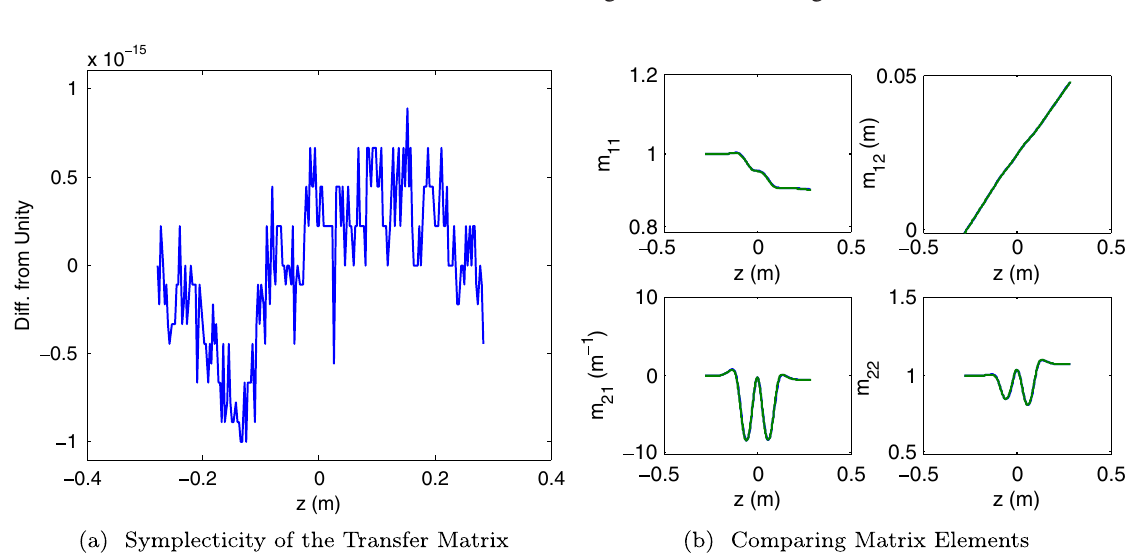
FIG. 7. (a) Comparison of the transfer matrix determinant to unity. (b) Comparison of the symplectic ray differentiation algorithm (blue) to the drift-kick-drift algorithm (green).